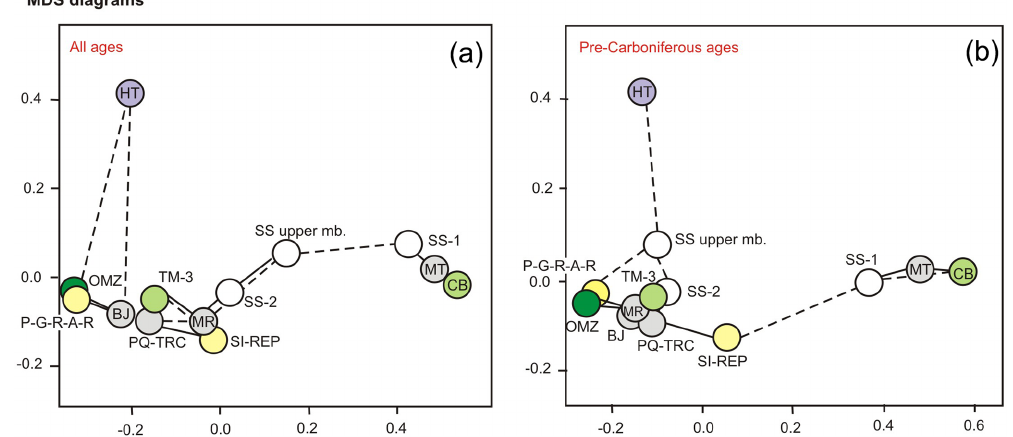
Figure 9. Multidimensional scaling diagrams (Vermeesch, 2018) applied to the U–Pb ages (90%–110% concordance) of detrital zircon grains from the Toca da Moura (TM-3) and Cabrela (CB) volcano-sedimentary complexes and the Santa Susana Formation (SS1, SS2, SS upper member) and different potential sources: OMZ (Linnemann et al., 2008; Pereira et al., 2008, 2012c), PLZ (Pereira et al., 2017a; Pérez Cácerez et al., 2017), and SPZ (Braid et al., 2011; Pereira et al., 2012a, 2014a; Rodrigues et al., 2014). Abbreviations: MT –